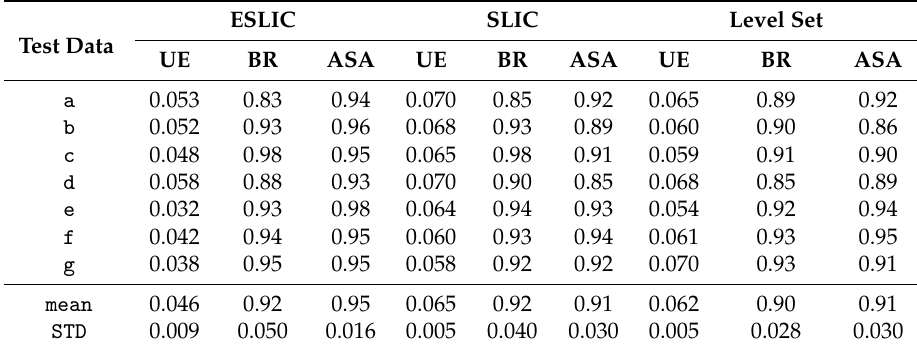
Table 1. Evaluation of the generated building masks using ESLIC and comparison to the SLIC and level set results, for the building samples a–g in Figure